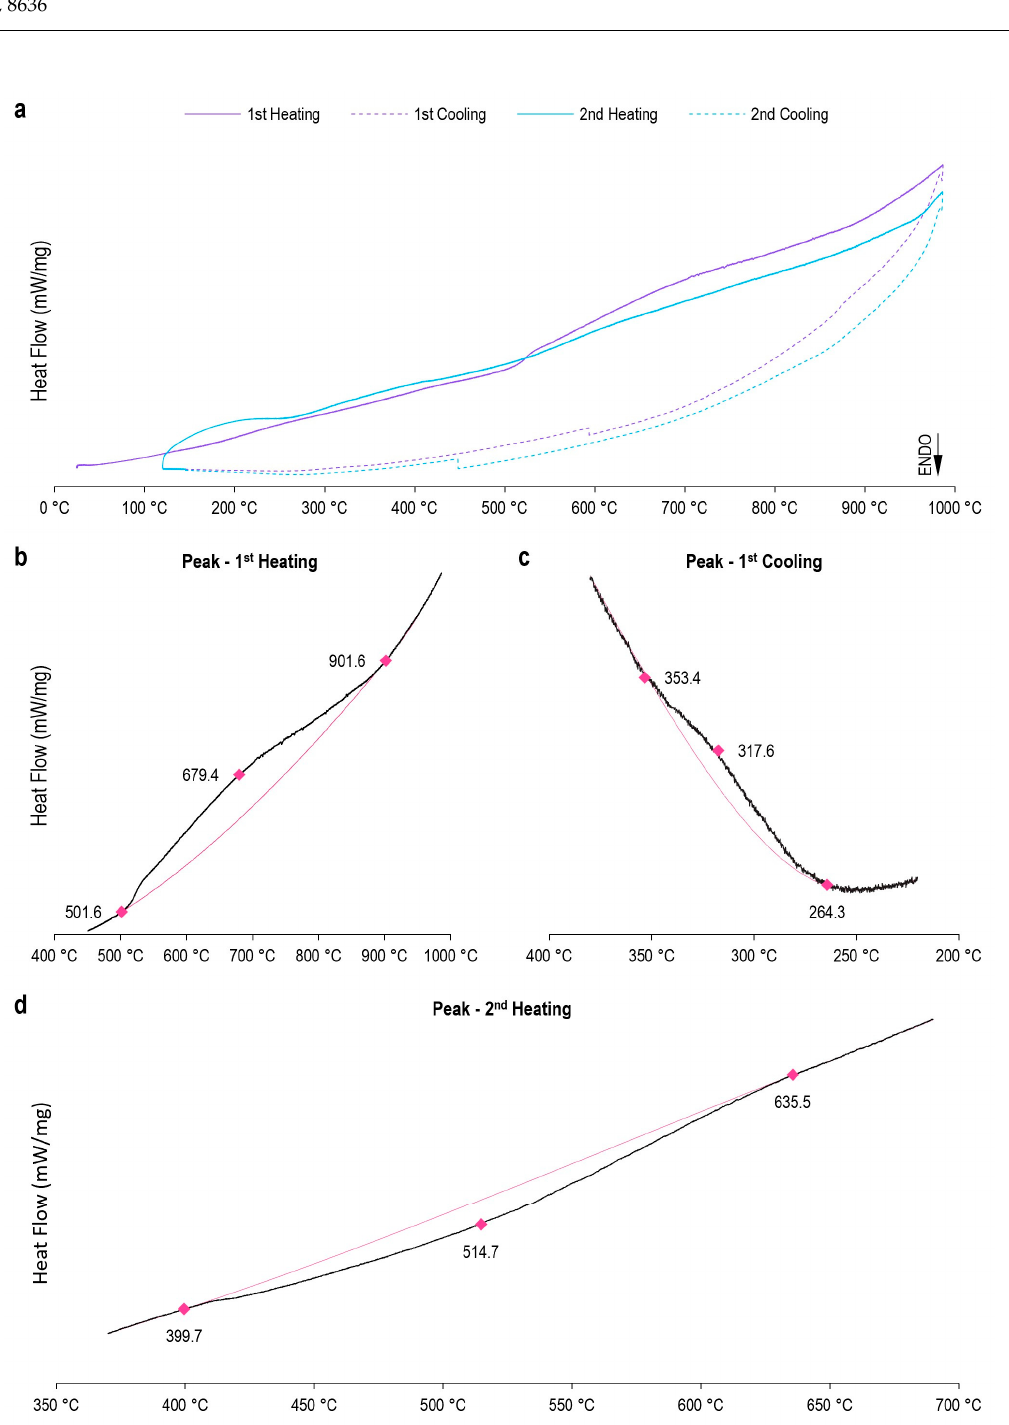
Figure 3. DSC of the Ti 10 Mo 8 Nb 6 Zr alloy. ( a ) Plotting the two heating-cooling cycles performed on a sample of Ti 10 Mo 8 Nb alloy in the final processing condition. The first cycle is indicated by purple. The second cycle is indicated by blue. The solid lines represent the heating. The dashed lines represent the cooling. Magnification of the area in which thermal events occur during ( b ) the first heating, ( c ) the first cooling, and ( d ) the second heating. The black lines represent the observed data. The pink lines represent the baseline. The initial, peak, and end temperatures of the thermal events are